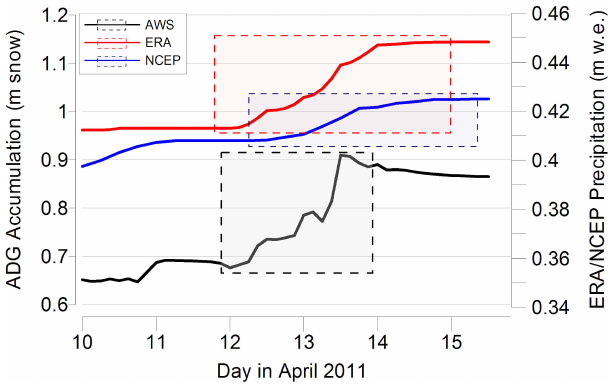
Fig. 4. Zoomed-in section of the Margaret accumulation plot (cor- responding to the grey box in Margaret in Fig. 2) showing the char- acteristics typical of a coincident event. ADG snow accumulation is on the left-hand y axis, and ERA/NCEP precipitation is on the right- hand y axis as in Fig. 2 (note axes are different scales for clarity). The dashed boxes indicate the different durations of the coincident event (defined as > 5mmsnowday − 1 and > 0.5mmw.e.day − 1 ) for each